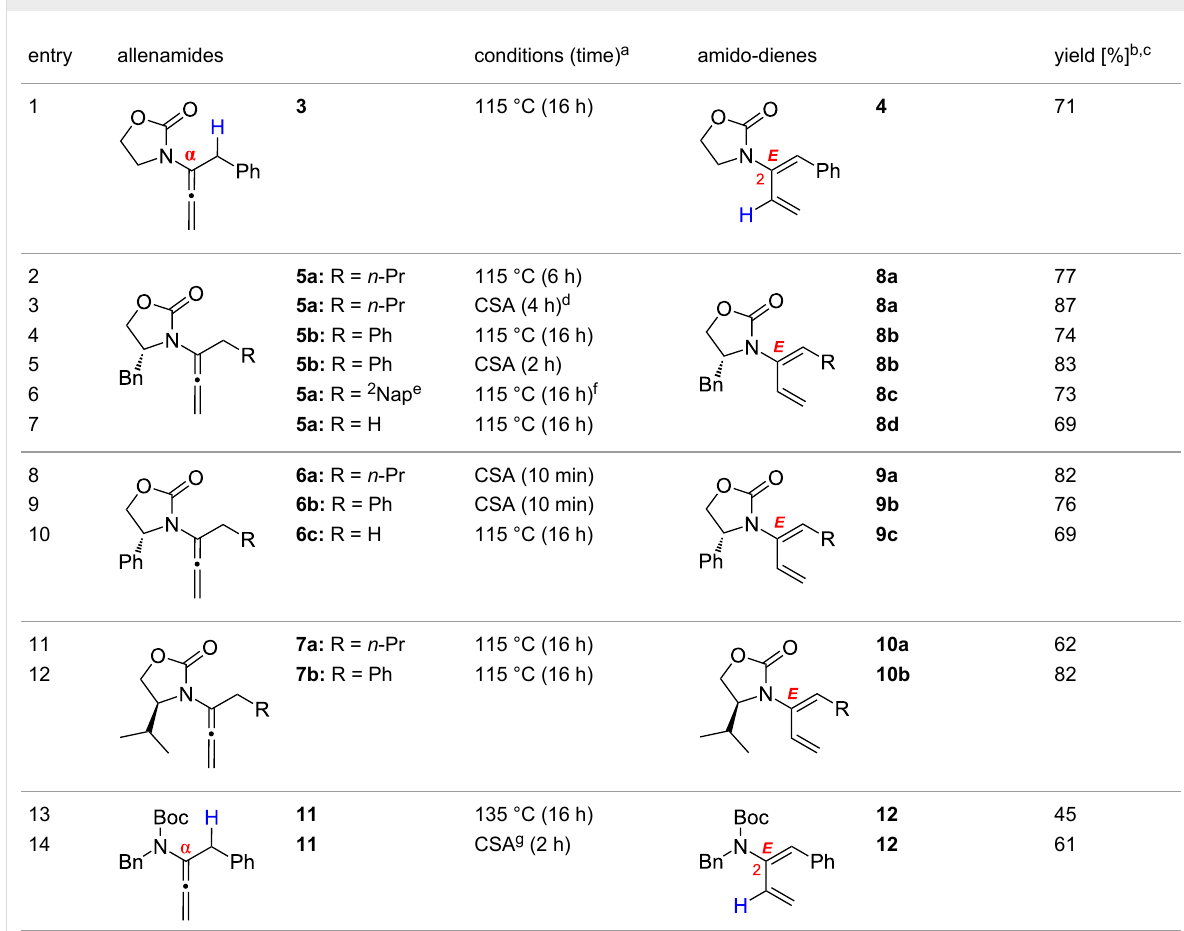
Table 2: Synthesis of